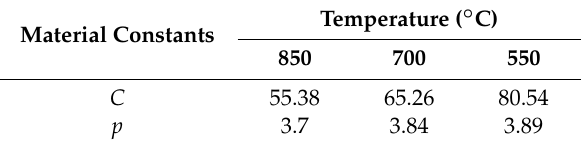
Table 5. Material constants of boron steel in the Cowper-Symonds model.